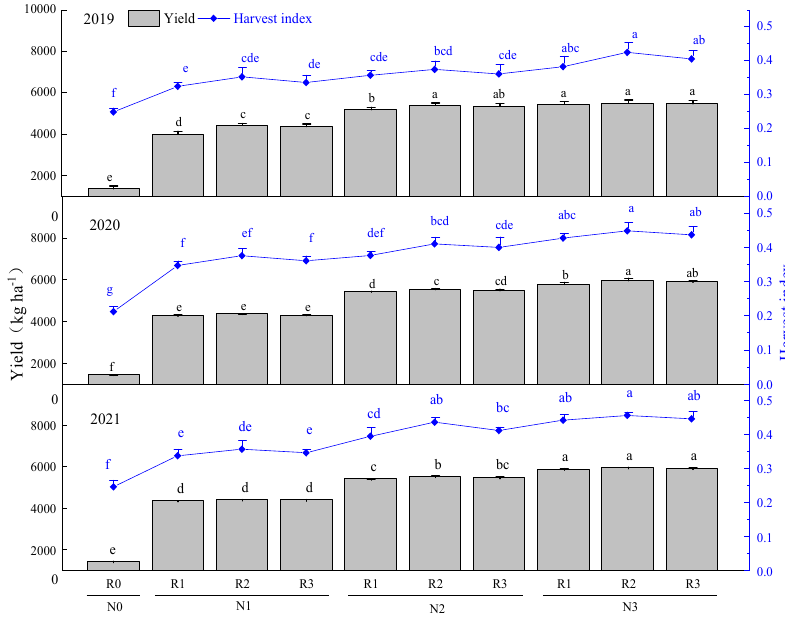
Figure 3. The effects of nitrogen application method on yield and harvest index. Values were means ± SD. Different letters above columns indicated significant difference within the same year under the treatments of four nitrogen levels and four ratios of basal to topdressing by LSD test (ANOVA) at the 5% level. Four nitrogen fertilization levels: N0, 0 kg ha − 1 ; N1, 120 kg ha − 1 ; N2, 180 kg ha − 1 ; N3, 240 kg ha − 1 . Four ratios of basal N to topdressing: R0, 0:0; R1, 7:3; R2, 6:4; R3, 5:5.